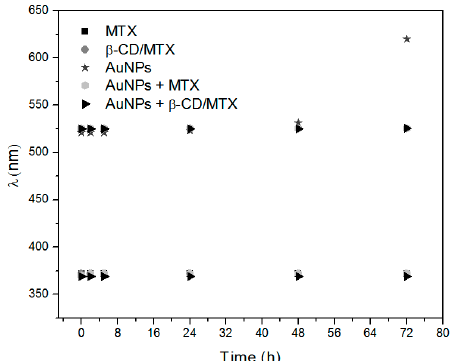
Figure 8. Schematic of the wavelengths of the characteristic absorption bands of MTX, IC, AuNPs + MTX, AuNPs + IC, and AuNPs at time zero and at 2, 5, 24, 48, and 72 h.